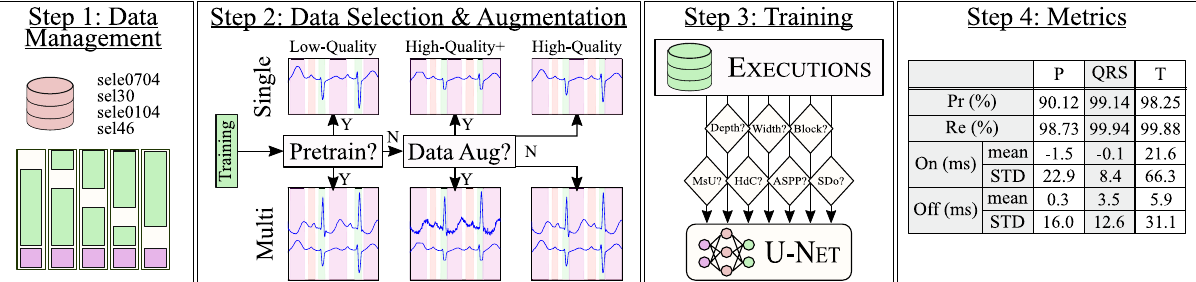
Figure 2. Developed pipeline. Step 1: random shuffle split of subjects (green: train, purple: test) in fivefolds. Step 2: the (single- or multi-lead) dataset is either used for training with low-quality labels or with high-quality annotations. In the latter case, ECG-tailored data augmentation is optionally applied (high-quality+). Step 3: a U-Net is instantiated per fold with a selection of execution parameters and trained with the selected data. Step 4: the fold-wise test sets are predicted and evaluated against the high-quality annotations. The employed metrics are precision and recall for detection and mean ± standard deviation (STD) of the onset and offset